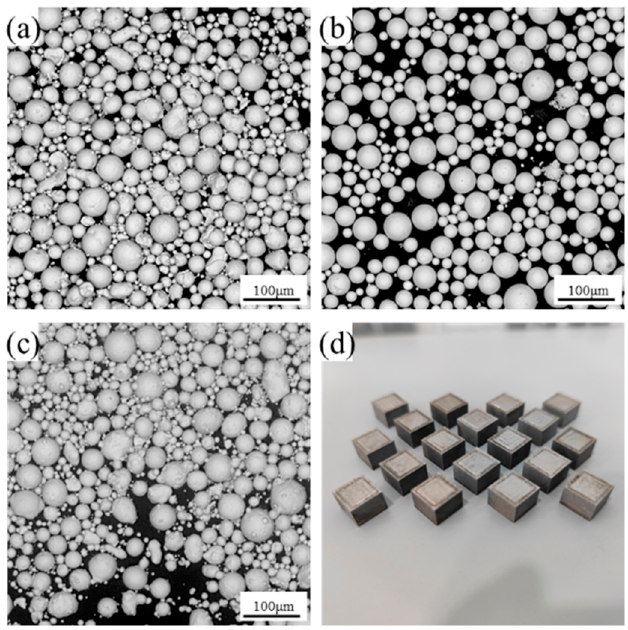
Figure 1. SEM images of ( a ) Fe elemental powder, ( b ) Cr elemental powder, ( c ) Co elemental powder and ( d ) as-built Fe-25Cr-15Co blocks .